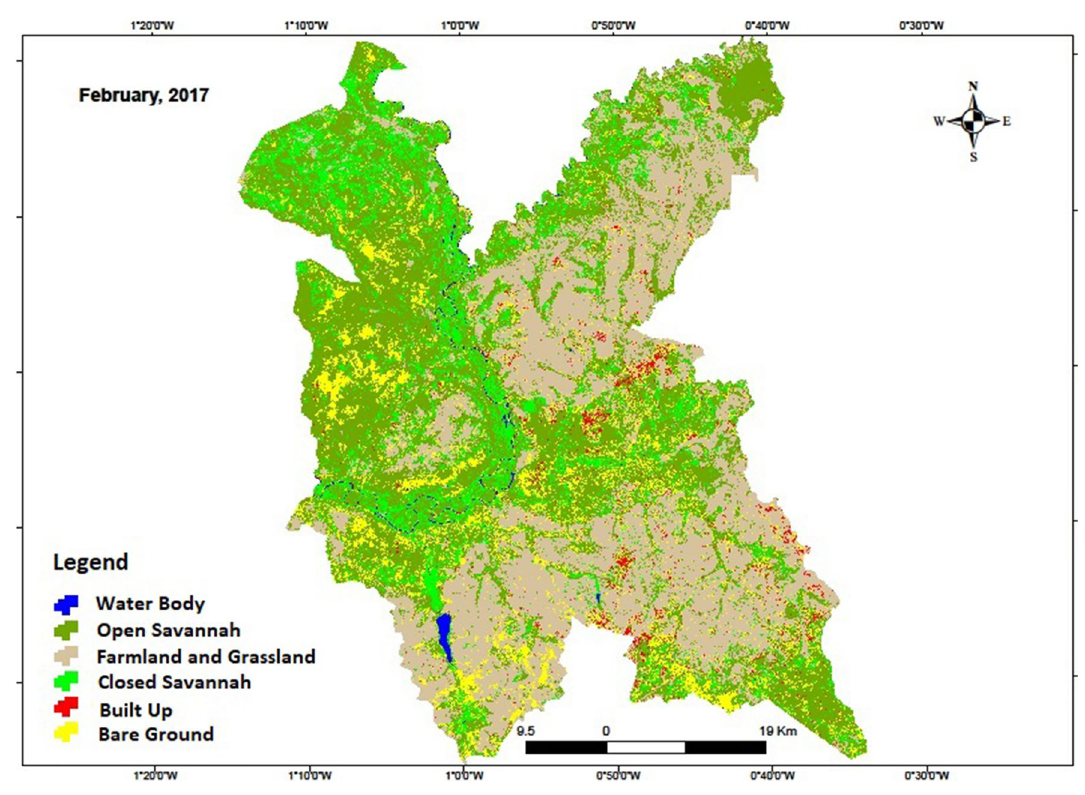
Fig. 7 Land use and land cover map of the Nawuni Catchment in 2017